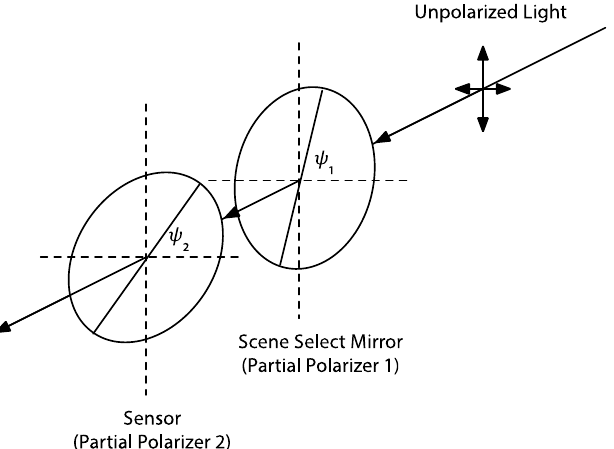
Figure 4. Representing the scene select mirror and sensor as a series pair of partial polarizers is useful when considering the calibration bias due to polarization. The first polarizer represents the scene select mirror, and the second polarizer represents the combined instrument polarization sensitivity due to the rest of the optical components within the sensor. The CrIS instrument uses a scene select mirror to direct radiance from the calibration references (Internal Calibration Target, ICT and deep space, DS), and the Earth scene (at multiple cross-track angles) into the instrument. Mirrors inherently introduce polarization that depends both on the angle of incidence and the orientation of the mirror. Unprotected gold was selected for the CrIS scene select mirror as it causes an extremely small level of signal polarization upon reflection for the infrared spectral region that CrIS covers. The CrIS sensor employs a 45° scene mirror rotated about the local optical axis such that the incident angle at the scene mirror is independent of scene mirror rotation angle. Thus, the amount of partial polarization introduced by the scene mirror is constant and independ- ent of scene mirror rotation angle. If this were the only consideration, the polarization effects would cancel in the standard calibration equation. However, the orientation of the partial polarization introduced by the scene select mirror does depend on the rotational position of the scene select mirror. The instrument also has a polarization sensitivity, which is primarily due to the beamsplitter and aft-optic dichroics, but also includes small contributions from the other optical elements within the sensor. The polarization sensitiv- ity and polarization plane of the instrument is constant and independent of the scene mir- ror rotation angle. While the level of polarization is constant for the scene select mirror and sensor indi- vidually, the combined polarization due to the scene select mirror and the sensor is a func- tion of the relative angle between the scene select mirror polarization axis at angle ψ 1 , which changes with rotation of the scene select mirror, and the instrument polarization axis, which is fixed and oriented at a constant angle, ψ 2 . Thus, the combined polarization depends on the scene mirror rotation angle, and the rotation of the reflection plane at the scene mirror will create a modulation of the measured signal. When the major axes of the polarization ellipses for the scene select mirror and sensor are aligned, transmission of unpolarized light is at a maximum ( T max ). When they are perpendicular, the transmission is at a minimum ( T min ). For a 360° rotation of the scene select mirror, there will be two maxima and two minima. For the same 360° scene select mirror rotation, there will also be four scene select mirror angles for which the major axes of the polarization ellipses are at 45° to one another. At these angles, the transmission will be the mean of the minimum and maximum response. A summary of these conditions is provided in Table 1.